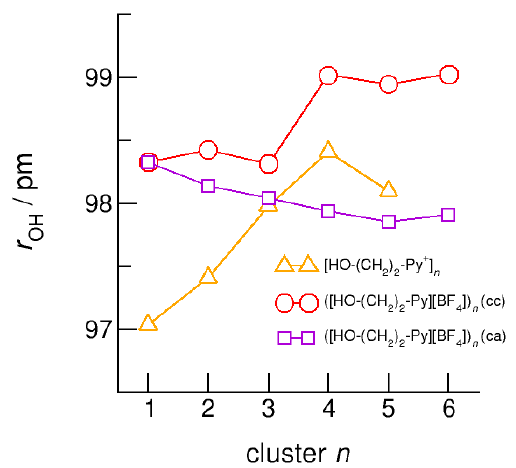
Figure 12. Average intramolecular bond lengths, r (OH), for the cationic clusters [HO-(CH 2 ) 2 -Py + ] n (triangles), ([HO-(CH 2 ) 2 -Py][BF 4 ]) n (c–c) (circles) and ([HO-(CH 2 ) 2 -Py][BF 4 ]) n (c–a) (squares) calculated at the B3LYP-D3/6–31+G* level of theory.